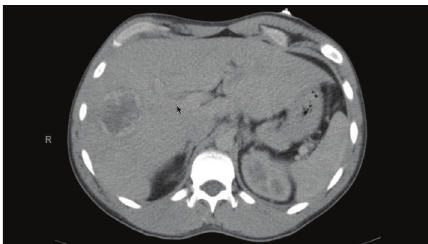
Figure 3: CT of the abdomen, revealing a single hypodense lesion with irregular foci and wall thickening in the right hepatic lobe.